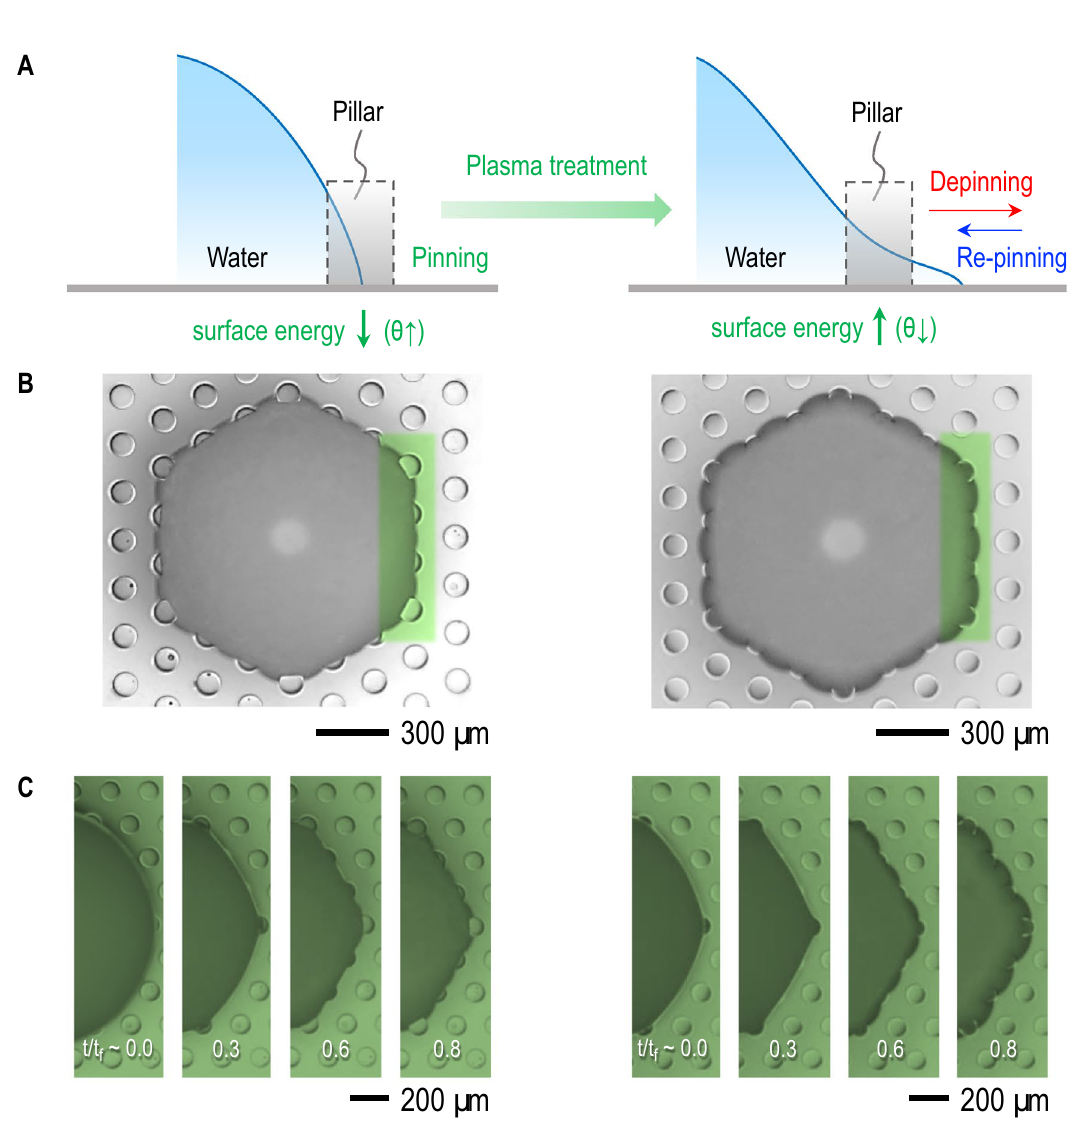
Figure 2. Pinning, depinning, and re-pinning dynamics of samples with and without surface modification through plasma treatment. ( A ) Initial low surface energy (or large contact angle) substrates is favorable for pinning of colloidal fluids between pillars (left) and plasma treatment to increase surface energy or decrease contact angle of substrates is essential for depinning to pass through between pillars (right). The final deposit shape is determined by re-pinning of the contact line. ( B ) Optical microscopic images for no treatment (left) and plasma treatment for 10 s (right) (both images were taken at t / t f ∼ 0.7) demonstrate contributions of pinning (left) and depinning (right) between pillars (Acquired with VHX-700FE, Keyence). ( C ) Temporal evolution of pinning by no treatment (left) and of depinning and re-pinning by plasma treatment for 10 s